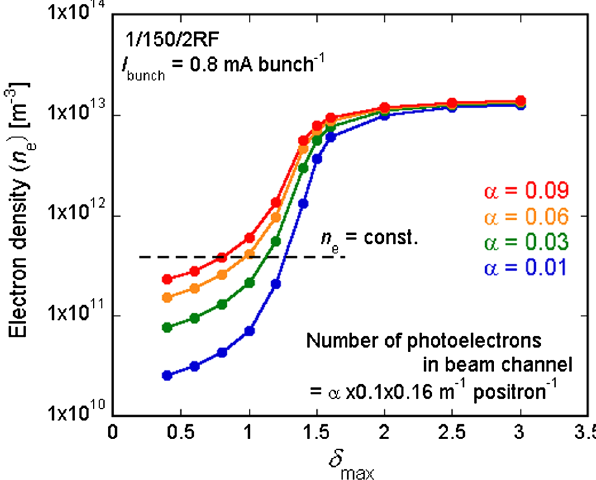
FIG. 13. Dependence of calculated electron density ( n e ) on the maximum SEY ( δ ) for several α , that is, the number of max photoelectrons in a beam channel, at a bunch fill pattern of 1 = 150 = 2 RF. The dotted line denotes the combination of α and δ that gives a constant n e . max